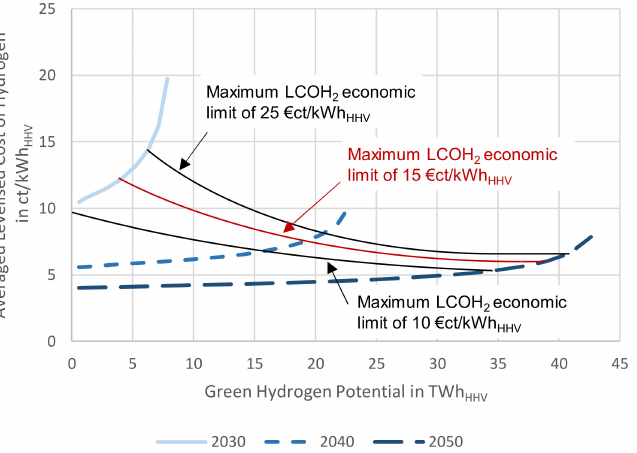
Figure 11. Relation between averaged levelised cost of hydrogen and economic green hydrogen potential. In addition, the maximum LCOH 2 economic limits (corresponding to the full-load hours) are visualised for 10, 15 and 25 € ct/kWh HHV